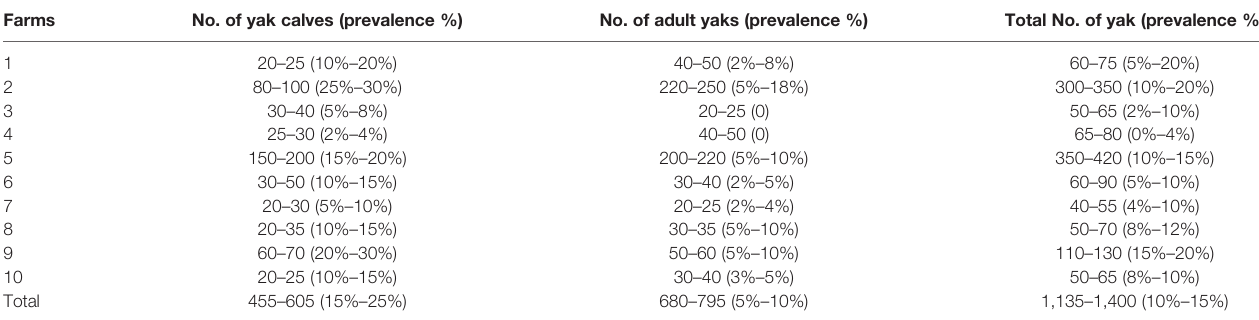
TABLE 1 | Estimation of the prevalence of diarrhea in yaks in Hongyuan on the